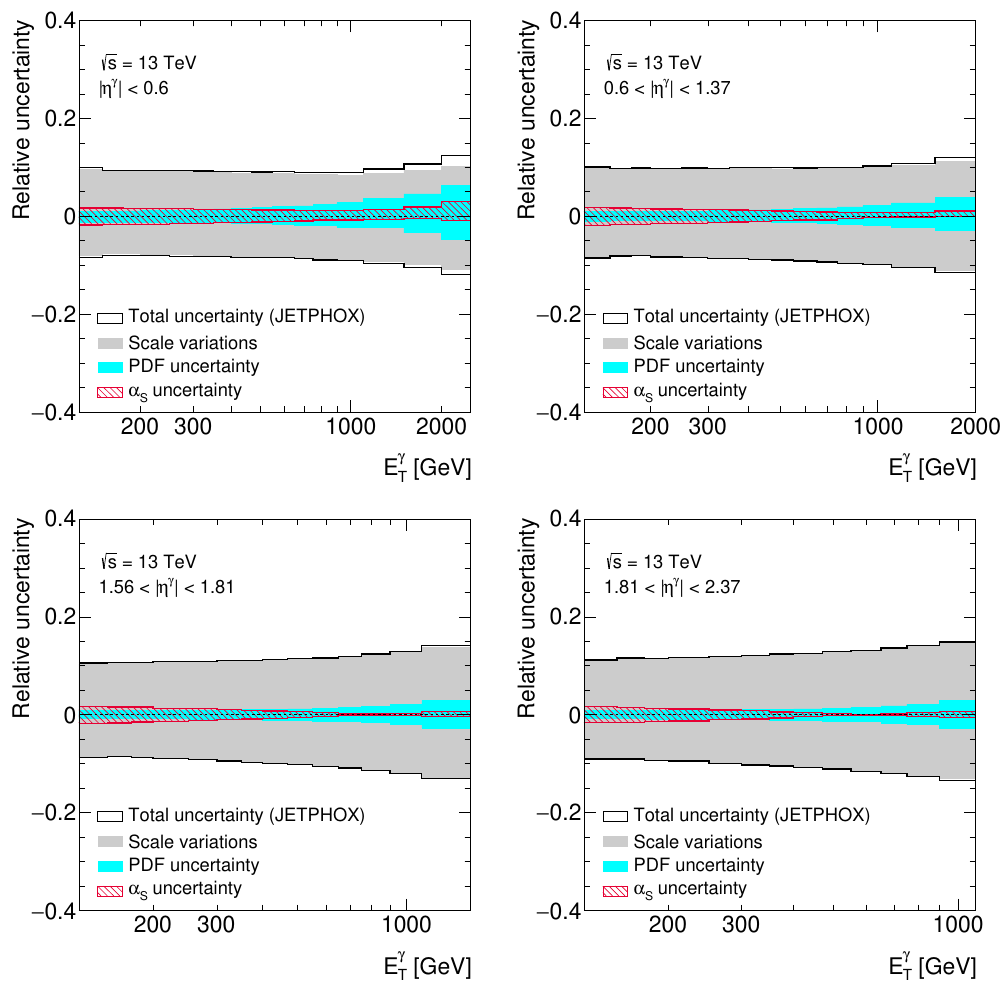
Figure 3 . The relative total theoretical uncertainty in the cross-section prediction of Jetphox as a function of E (cid:13) in di(cid:11)erent regions of j (cid:17) (cid:13) j . The uncertainty from the scale variations, the T uncertainty from the PDFs and the uncertainty from the value of (cid:11) s are also